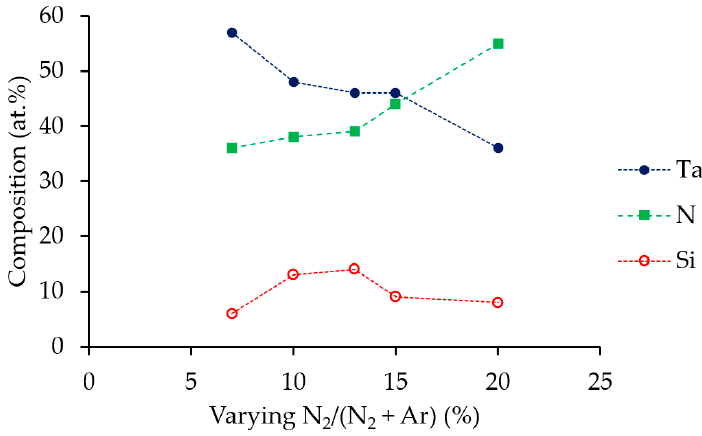
Figure 3. Composition of the Ta–Si–N films as a function of the N 2 percentage in the gas mixture.